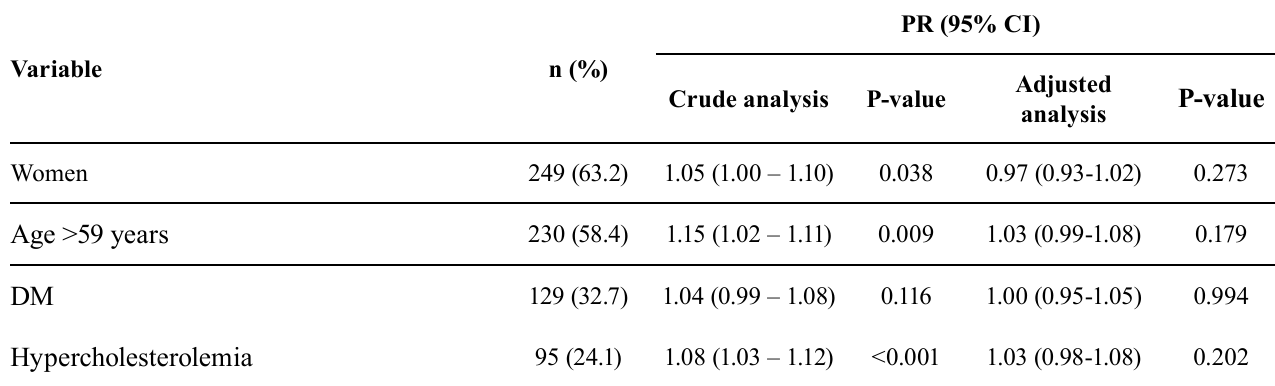
TABLE III – Crude and adjusted analysis of the independent variables related to the occurrence of drug discrepancy among the study participants hospitalized in the surveyed hospital,